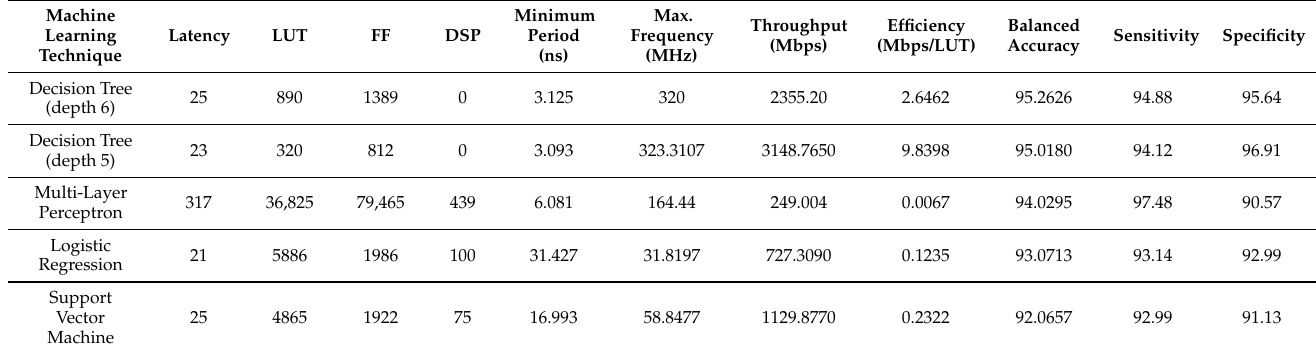
Table 3. Resource Comparison of the Implemented Machine Learning